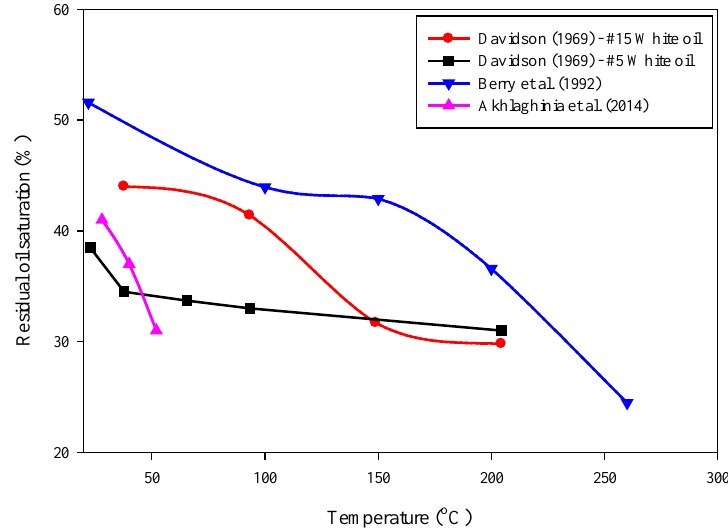
Figure 8. Effect of temperature on residual oil saturation in the gas/oil system. Figure 8. E ff ect of temperature on residual oil saturation in the gas / oil